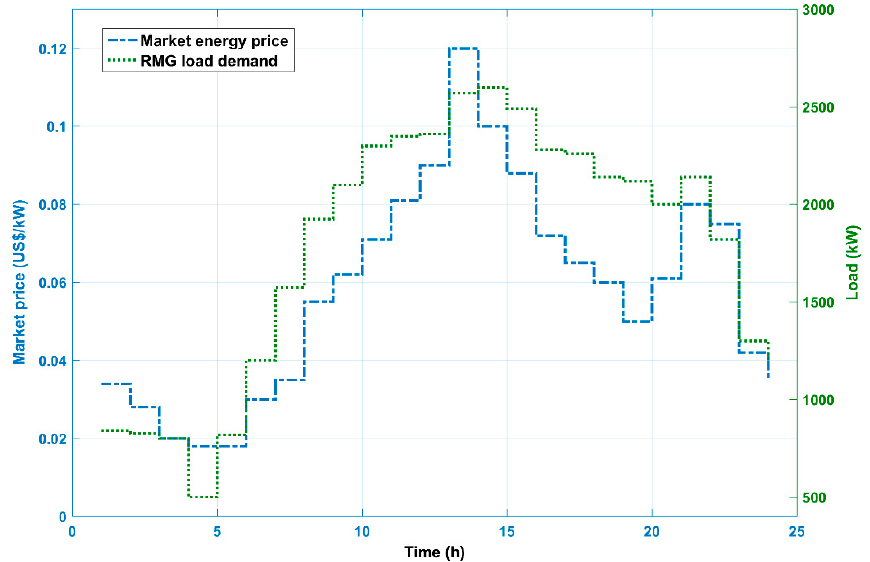
Figure 2. Hourly market energy prices and electricity load demands for the case studies.